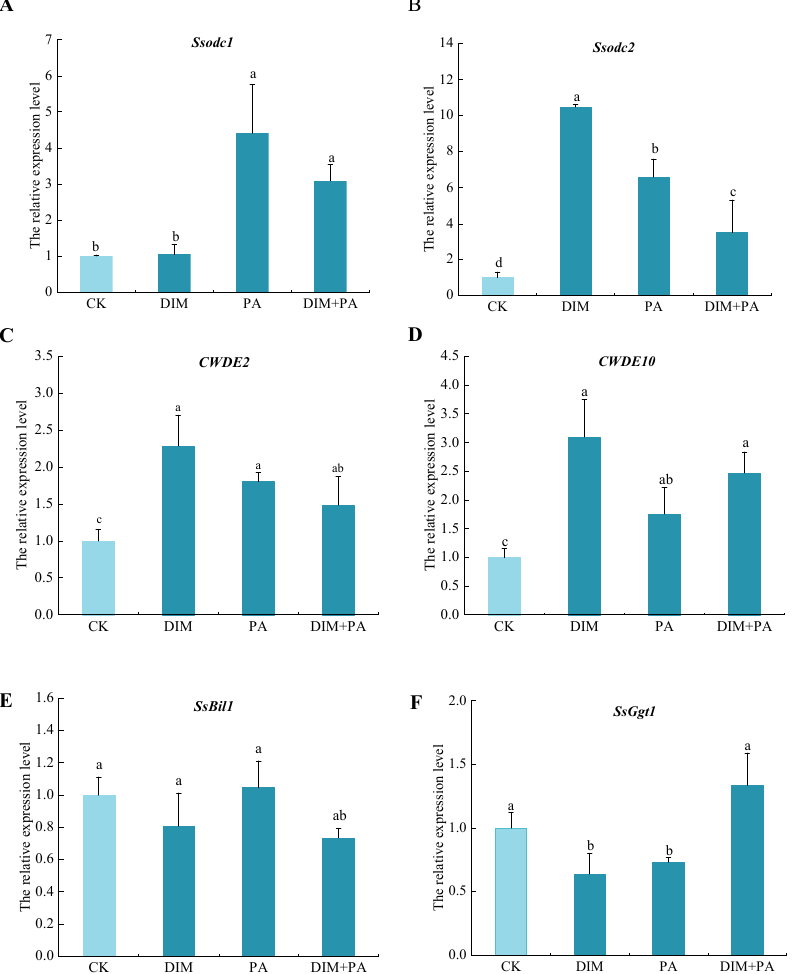
Figure 7. Relative expression level of six target genes of S. sclerotiorum mycelia incubated for 48 h in PDA medium containing different treatments. Different bars with different letters (a, b, c) are significantly different ( p < 0.05). The treatments were: CK, DIM (0.8 mg · L − 1 ), PA (0.1 mg · mL − 1 ), and DIM (0.8 mg · L − 1 ) + PA (0.1 mg · mL − 1 ), respectively. ( A – F ) indicated that the relative expression level of Ssodc1, Ssodc2, CWDE2, CWDE10 , SsBil1 and SsGgt1